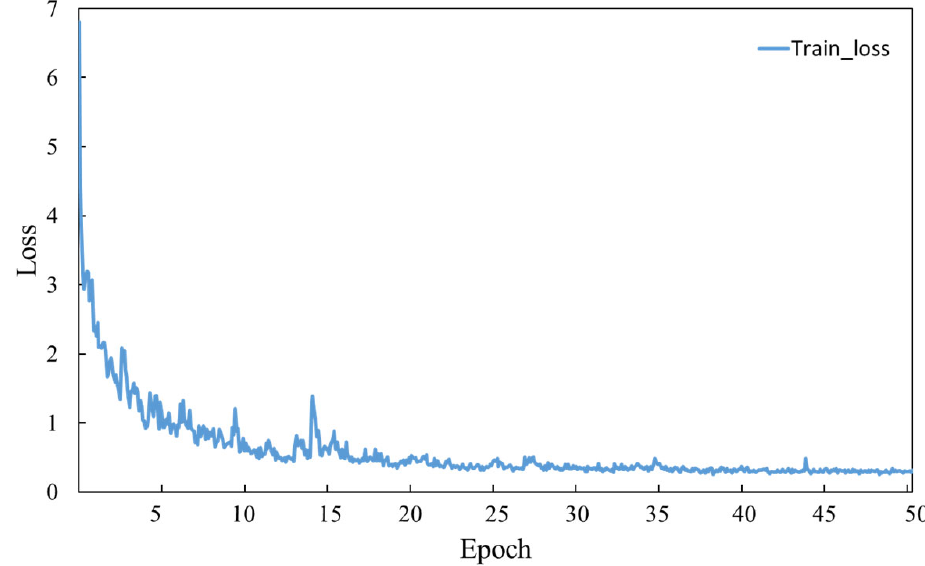
Figure 7. Loss curve when the network is pre ‐ trained.